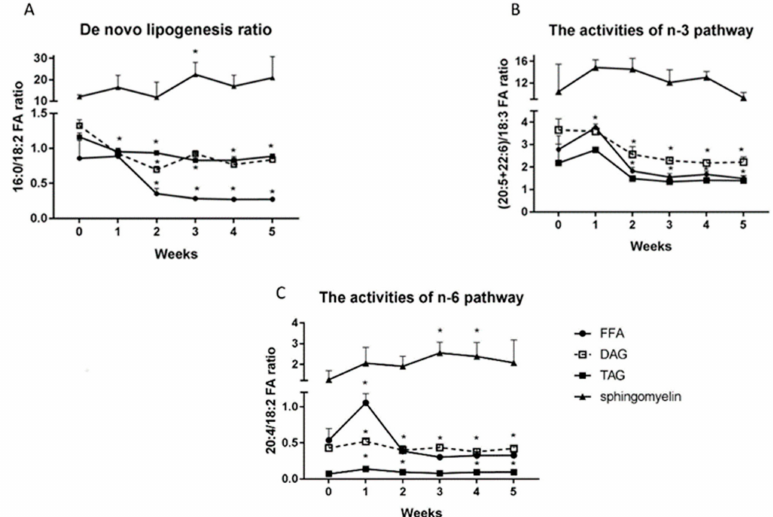
Figure 7. De novo lipogenesis ratio (16:0 / 18:2) ( A ), the activities of n-3 pathway ((20:5 + 22:6) / 18:3) ( B ) and the activities of n-6 pathway (20:4 / 18:2) ( C ) in triacylglycerols, diacylglycerols, free fatty acids and sphingomyelin fractions in liver homogenates from control group (0 week) and HFD group at the end of each experimental week (1, 2, 3, 4, and 5). Lipogenesis ratio and activities of n -3 and n -6 pathways were calculated based on fatty acid composition measured by GLC method. The data are expressed as the mean ± S.D. and are based on six independent determinations ( n = 6). * p < 0.05 significant di ff erence vs control group (0